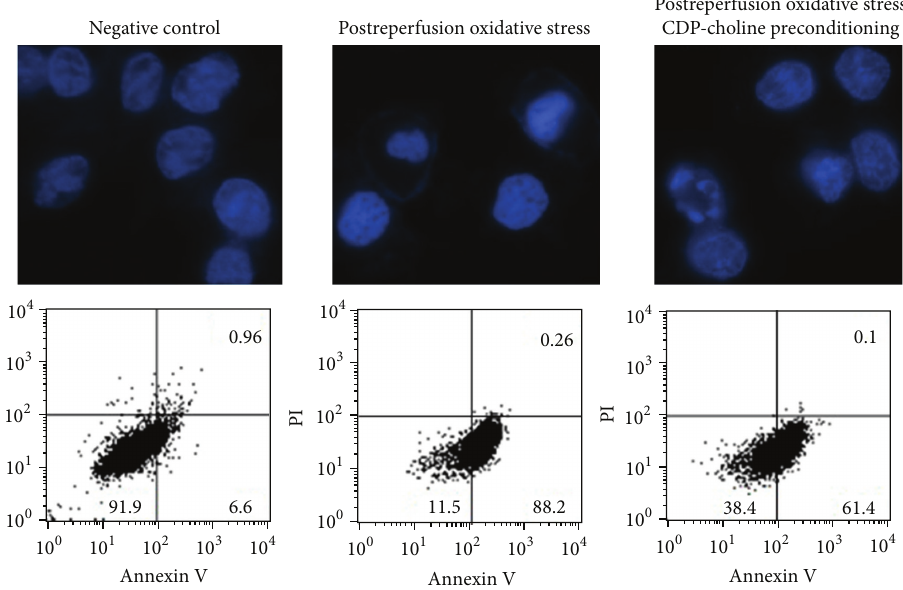
Figure 4: CDP-choline attenuates oxidative stress-induced postreperfusion apoptosis. Cardiac myocyte cultures were subjected to coverslip hypoxia/reperfusion. To induce oxidative stress, 5 mM H 2 O 2 was added immediately after reperfusion (Postreperfusion oxidative stress). Preconditioning was performed by incubating the cells with CDP-choline (50 mg/mL) prior to reperfusion (Postreperfusion oxidative stress CDP-choline preconditioning). Cells were further incubated for 6 hrs. A group of untreated cells was included as control (negative control). To assess changes in cell nucleus morphology, the cells were fixed and stained with Hoechst 33342 fluorescent dye (upper panel). Changes in nuclear morphology associated with apoptosis, such as nuclear condensation and fragmentation, were detected by fluorescence microscopy (63X). Apoptosis and necrosis were evaluated by flow cytometry analysis of cells labeled with Annexin-V-FLUOS (Annexin V) and propidium iodide (PI) (lower panel). The proportion of labeled cells is depicted in the lower panel. The proportion of viable cells, with low Annexin and low PI staining, is shown in the left, lower quadrant of each dot plot. Apoptotic cells, with high Annexin and low PI staining, are depicted in the right, lower quadrant. Necrotic cells, with high Annexin and high PI staining, are showed in the right, upper quadrant. Results shown are representative figures from three independent